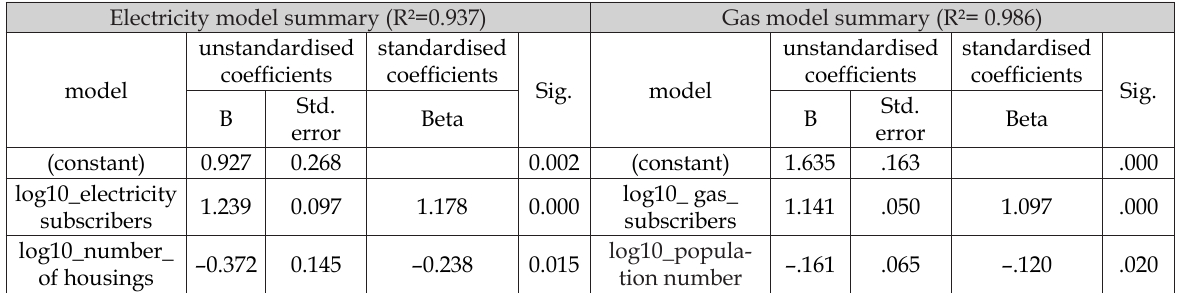
Table 2. Summary of the gas and electricity model.